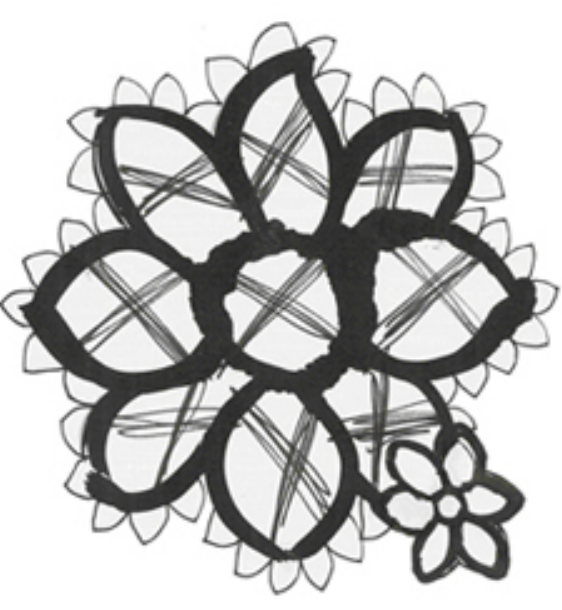
FIGURE 1. The ego’s relationship to the life mission, or purpose in life. The talents supporting one’s true purpose in life relate to one’s true self, depicted here as the big flower, while the ego is the small flower that centers on a secondary or (as seen here) a tertiary purpose in life and the associated talents. The drawing is made by a tinnitus patient, a female artist who could not work because of her disease. In therapy, she came to a sudden realization of her personal life mission, and shortly after this breakthrough, her tinnitus disappeared.